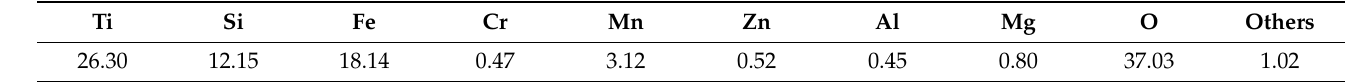
Table 1. Composition of electric smelting dust of ilmenite concentrate (wt%).